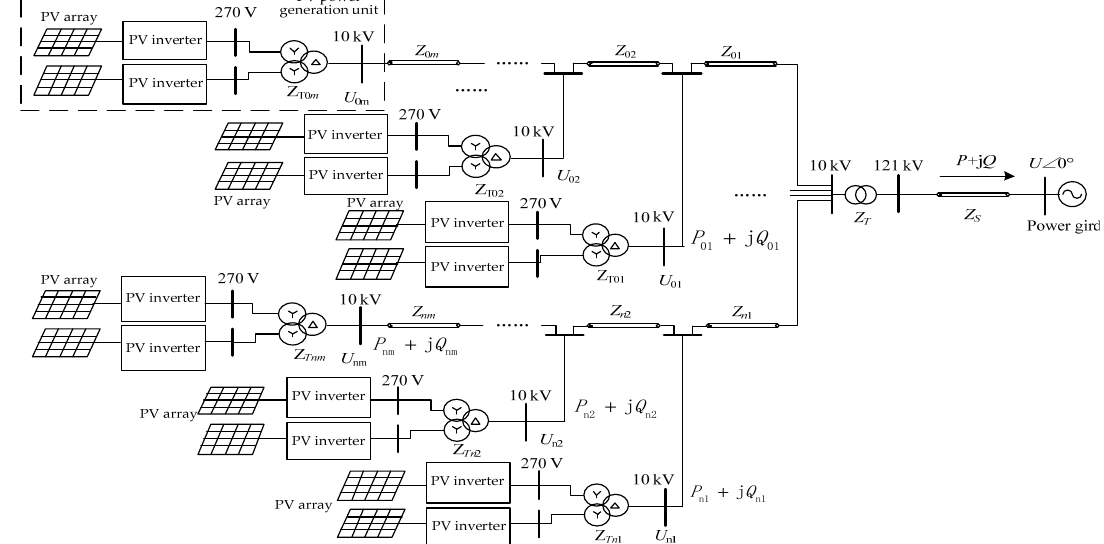
Figure 2. Line impedance of the centralized PV cluster.